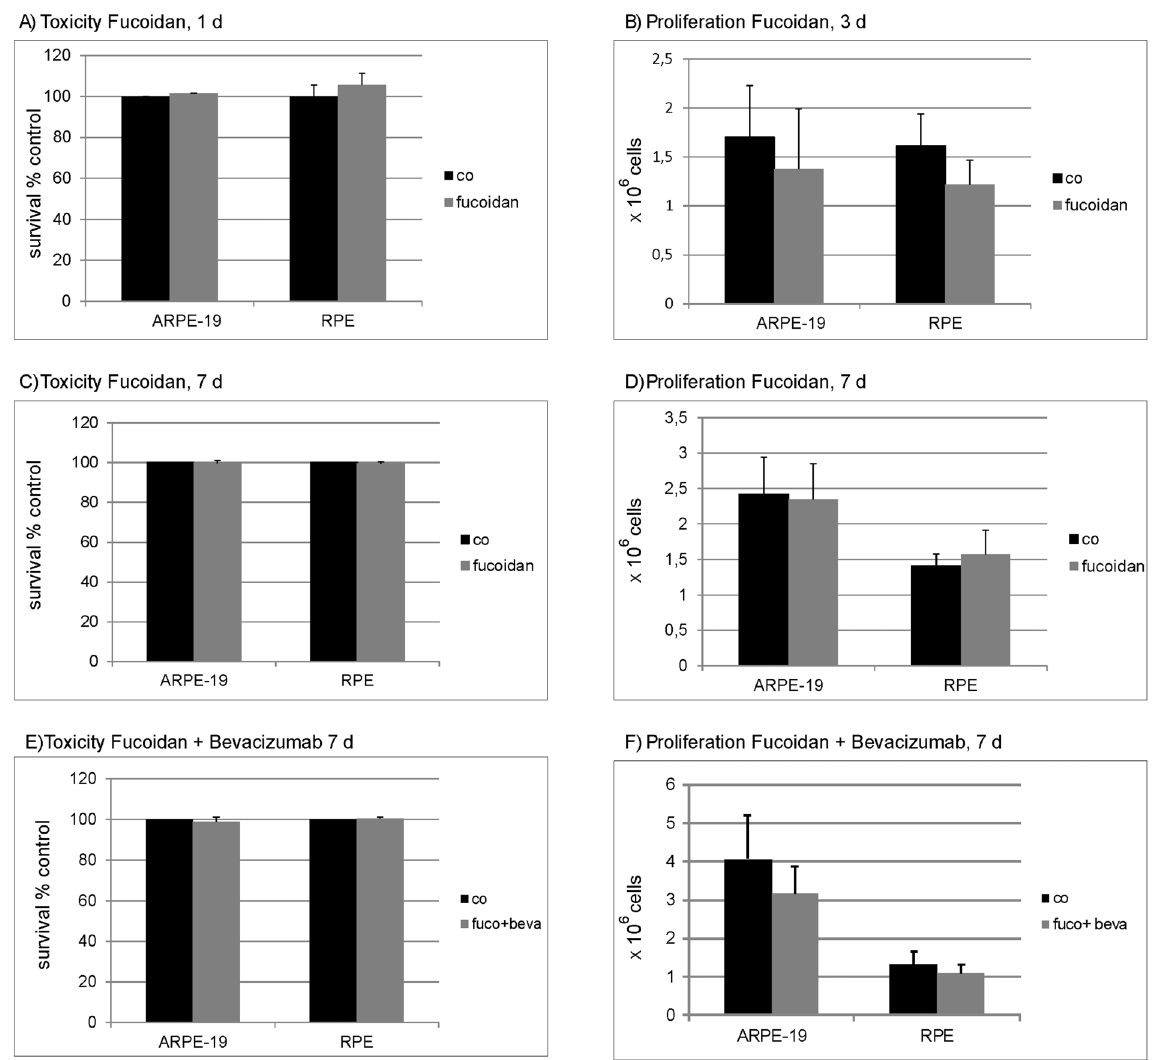
Figure 1. Toxicity and proliferation. To investigate toxicity, RPE or ARPE-19 cells were treated with 100 m g/ml fucoidan for 24 hours (A) or 7 days (C). In addition, cells were treated with a combination of fucoidan (100 m g/ml) and bevacizumab (250 m g/ml) for 7 days (E). Toxicity was measured with MTT test. Fucoidan did not exert toxic effects on RPE or ARPE-19 cells at any tested application (A,C,E). To investigate proliferation, a defined number of cells were seeded, cells were treated with fucoidan (100 m g/ml) and cell number was assessed after 3 days (B) and 7 days (D). In addition, cells were treated with a combination of fucoidan (100 m g/ml) and bevacizumab (250 m g/ml) and cell number was assessed after 7 days (F). No significant influence on proliferation was found. Significance was determined with student’s t-test. Co = untreated control, fuco = fucoidan, beva = bevacizumab.